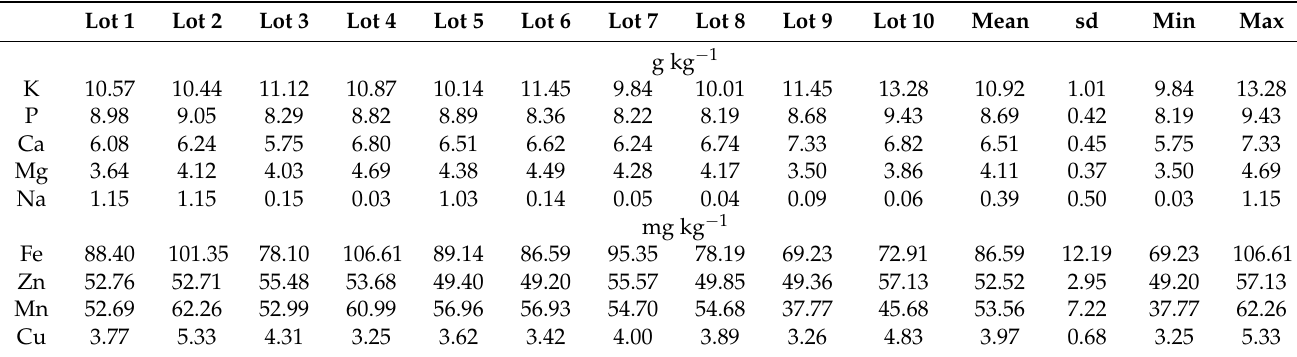
Table 2. Mineral and trace element contents of rapeseed meal samples. Mean, standard deviation, and range of values obtained from different lots collected between July 2018 and September 2019 ( n = 10) *.